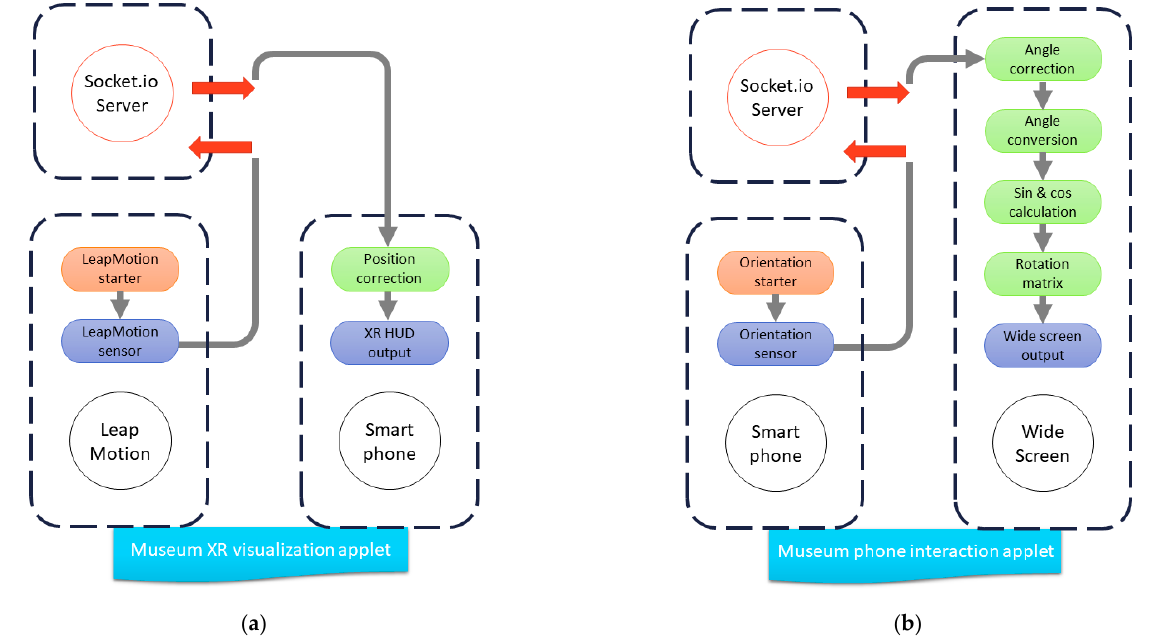
Figure 6. Oriented graphs of data flow and the device part of the distributed MusExp application that was created and explored using the DEMOS platform. ( a ) The XR visualization part of the MusExp application that illuminates a virtual artifact seen on an HUD reflecting the user’s smartphone screen according to data coming from the LeapMotion device that detects the user’s finger position. ( b ) The interaction part of the MusExp application that rotates an artifact displayed on a wide screen according to data received from the user’s smartphone orientation sensor.